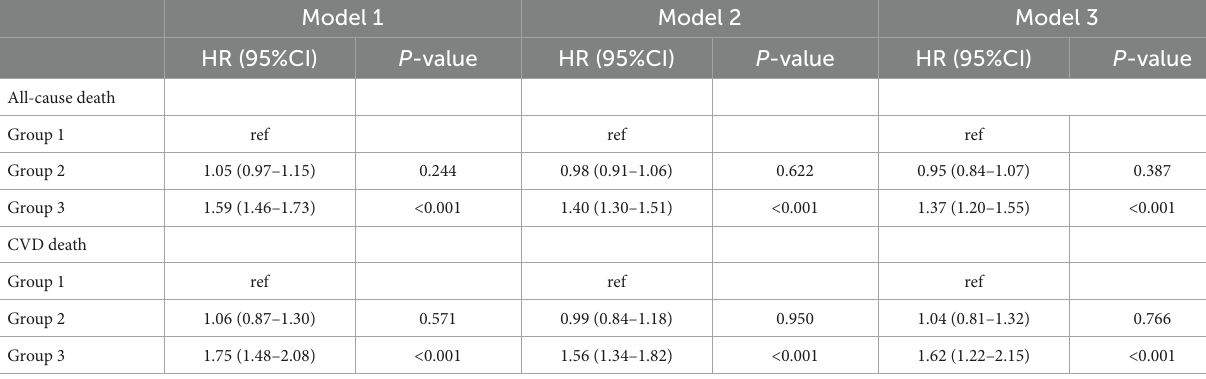
TABLE 2 The association between PIV and all-cause and CVD mortality.